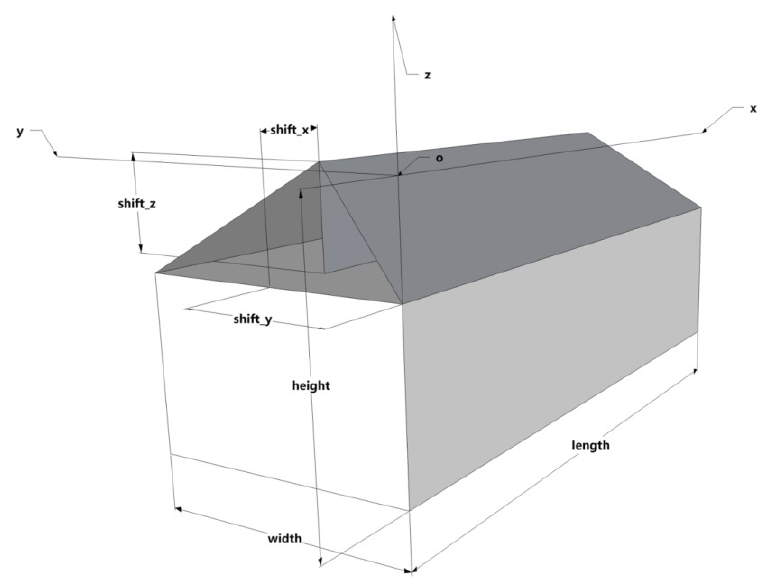
Figure 3. Shape parameters of a hipped